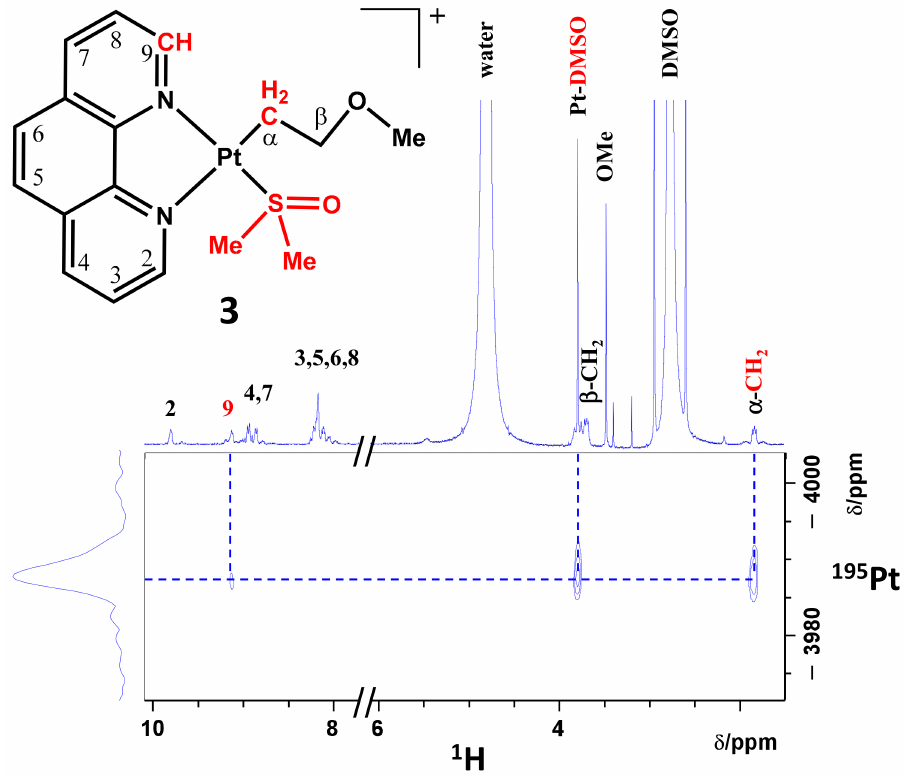
Figure 2. [ 1 H, 195 Pt]-HETCOR NMR spectrum of the [Pt( η 1 -C 2 H 4 OMe)(DMSO)(phen)]Cl ( 3 ) complex dissolved in a D 2 O/DMSO = 98:2 mixture. In the above-reported schematic molecular structure, the groups whose H atoms 1 H NMR signals are coupled with the 195 Pt are evidenced in